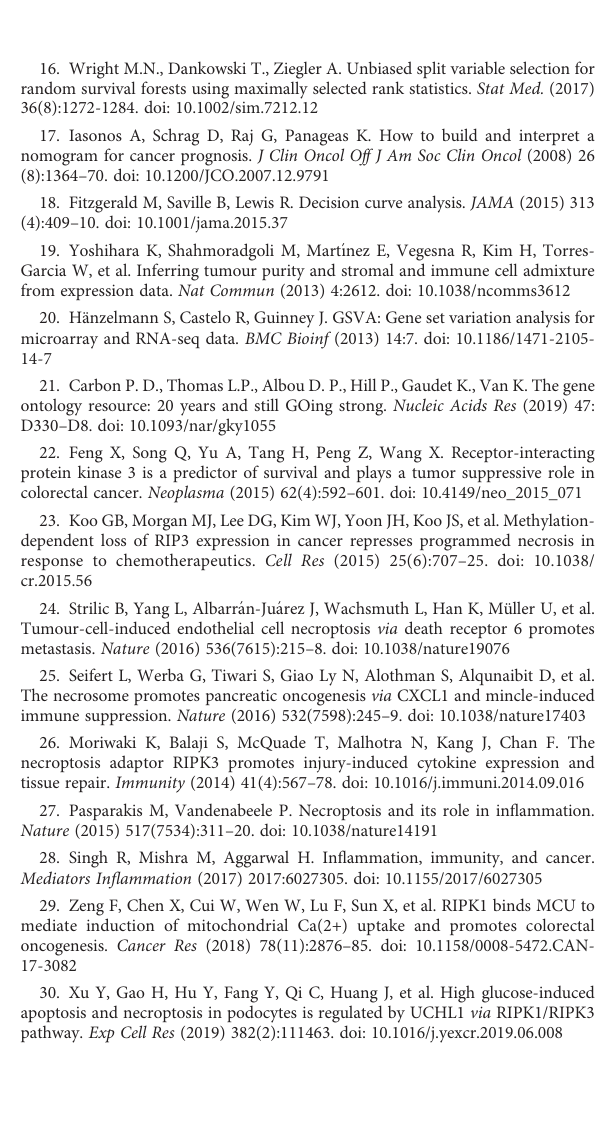
SUPPLEMENTARY TABLE S1 Clinical characteristics of our own COAD